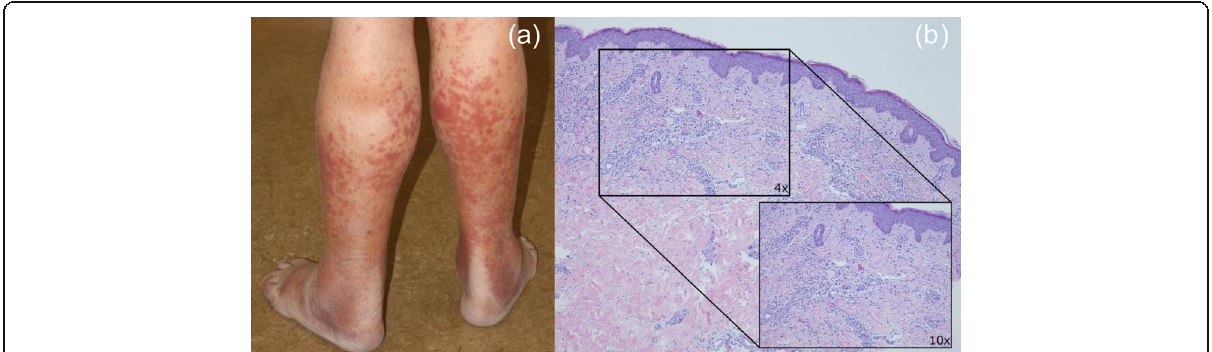
Fig. 1 Details of dermal lesions: Close-up of the erythematous plaques ( a ). Lesions visible on the dorsal side of the calves. b Skin biopsy of erythematous plaques on the dorsal side of the thumbs. HE stain, 4x magnification with 10x inlay. Ribbon-like histiocytic infiltration of the upper corium with numerous neutrophilic granulocytes, granulomatous formations and edema with few perivascular lymphocytes and without vasculitis or viral cytopathic